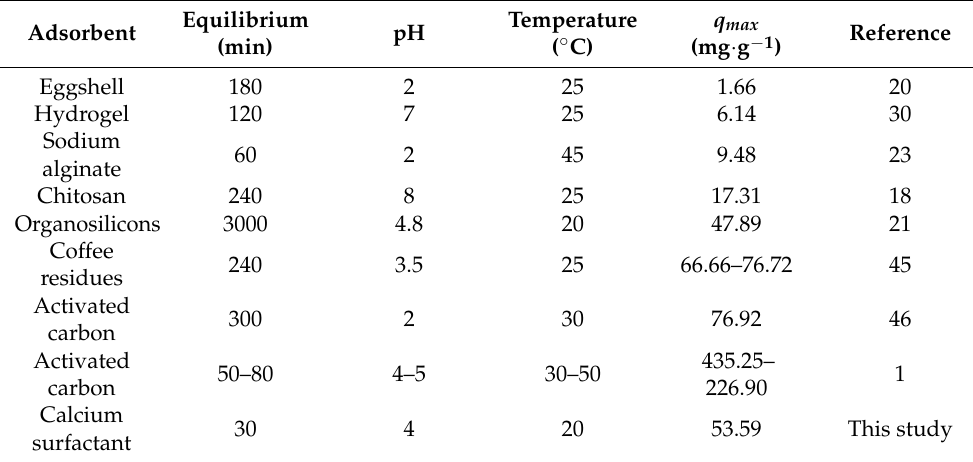
Table 7. Comparison of MR adsorption capacities achieved by different